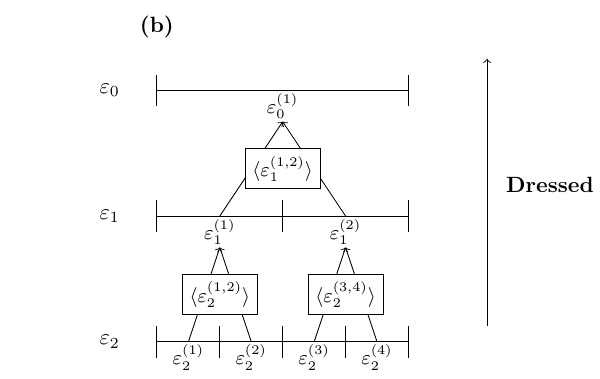
Figure 1. A basic rainfall model, graphically illustrated. The left-hand side of the image is the dressing procedure, whereas the right-hand side is the Fig. 1. A basic rainfall model, graphically illustrated. The left hand side of the image is the dressing procedure, whereas the right hand side is the generation.